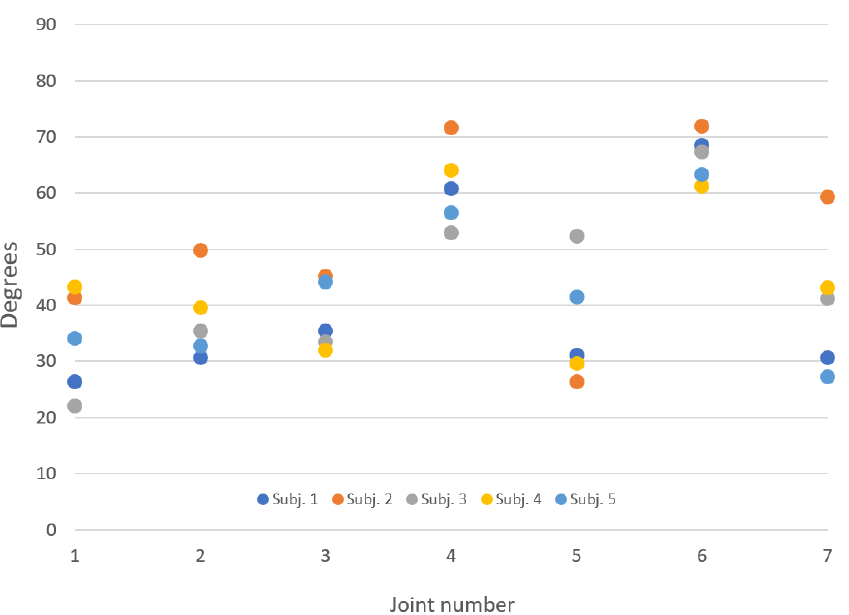
Figure 10. The figure shows for each subject (represented by the colored balls) a typical maximum angular excursion of the seven joints (numbered as in Figure 2). Subject’s, in degrees, for each of the 7